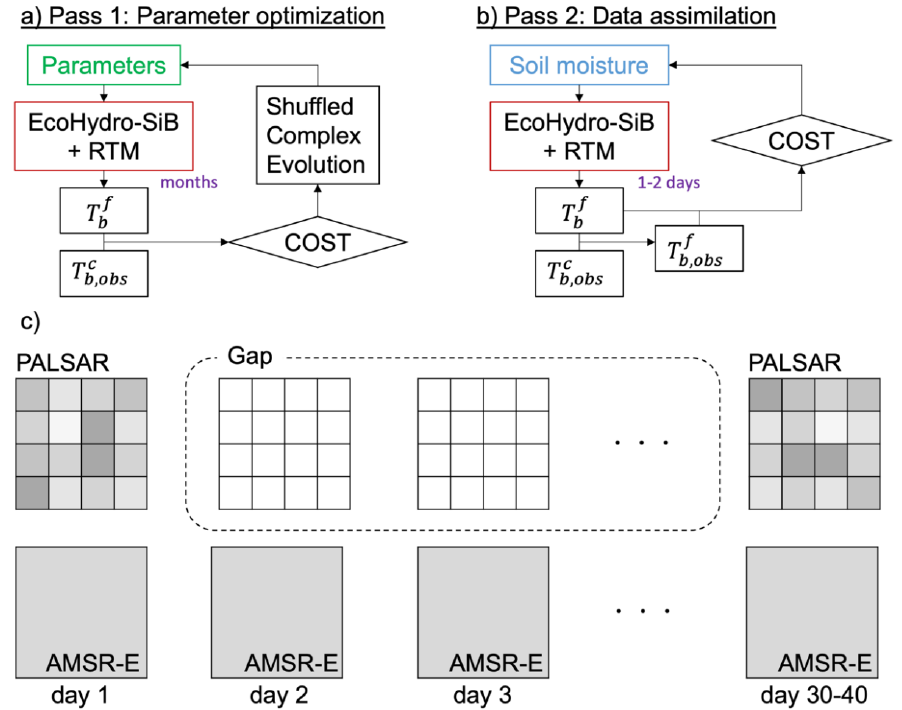
Figure 1. Flow chart of the integrated passive and active downscaling (I-PAD) system. ( a ) Parameter optimization process and ( b ) data assimilation process. The cost functions are calculated based on coarse resolution observed brightness temperature 𝑇 𝑏,𝑜𝑏𝑠𝑐 and fine resolution simulated brightness temperature 𝑇 𝑏𝑓 . The superscripts c and f represent coarse and fine resolutions, respectively. ( c ) The target of the current study.